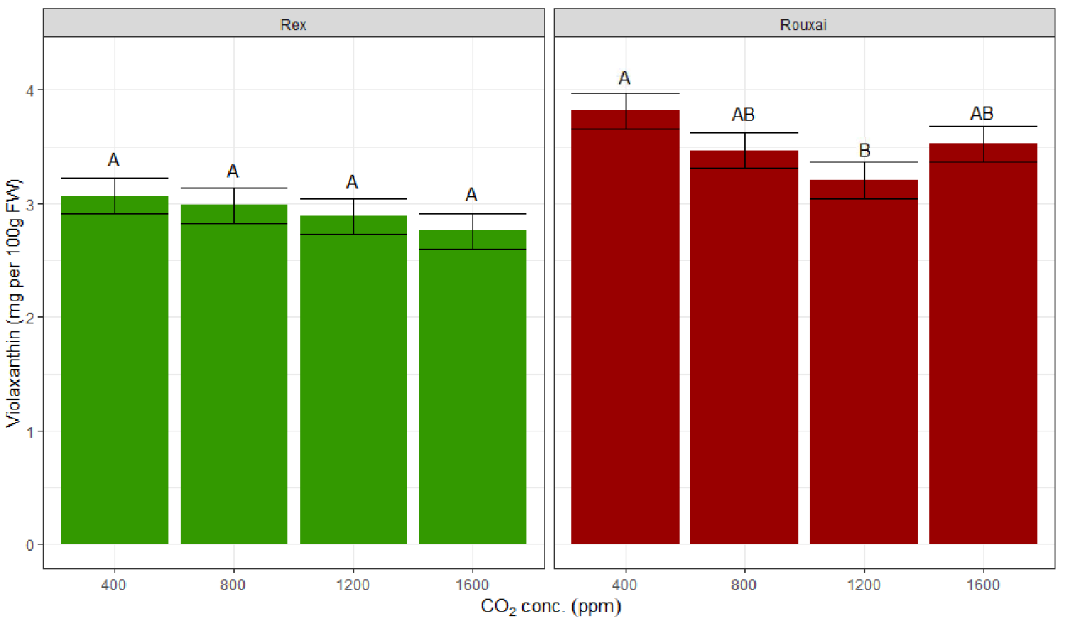
Figure 6. Violaxanthin concentration of lettuce ‘Rex’ and ‘Rouxai’ after 21 days with increasing concentrations of CO 2 . Data represent estimated marginal means and standard error as calculated by five plants across four replicates in a complete randomized block design. Letters represent mean separation comparison using Tukey’s Honestly Significant Difference (alpha = 0.05). Table 1. The effect of increasing concentrations of CO 2 on lettuce varieties ‘Rex’ and ‘Rouxai’ for lutein, anthocyanin, and chlorophyll content. Separation was determined with the linear model (Variable = Variety * × CO 2 Concentration + Light Intensity + Random Effects) using Tukey’s HSD (alpha = 0.05). Data represent five plants per cultivar per treatment per replicate with four replicates over time *.